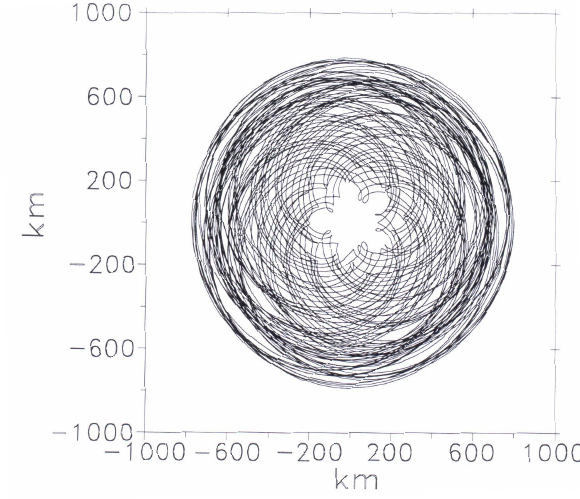
Fig. 1. The solar orbit due to the inner (terrestrial) planets in the time interval 1920–2010 in units of km.